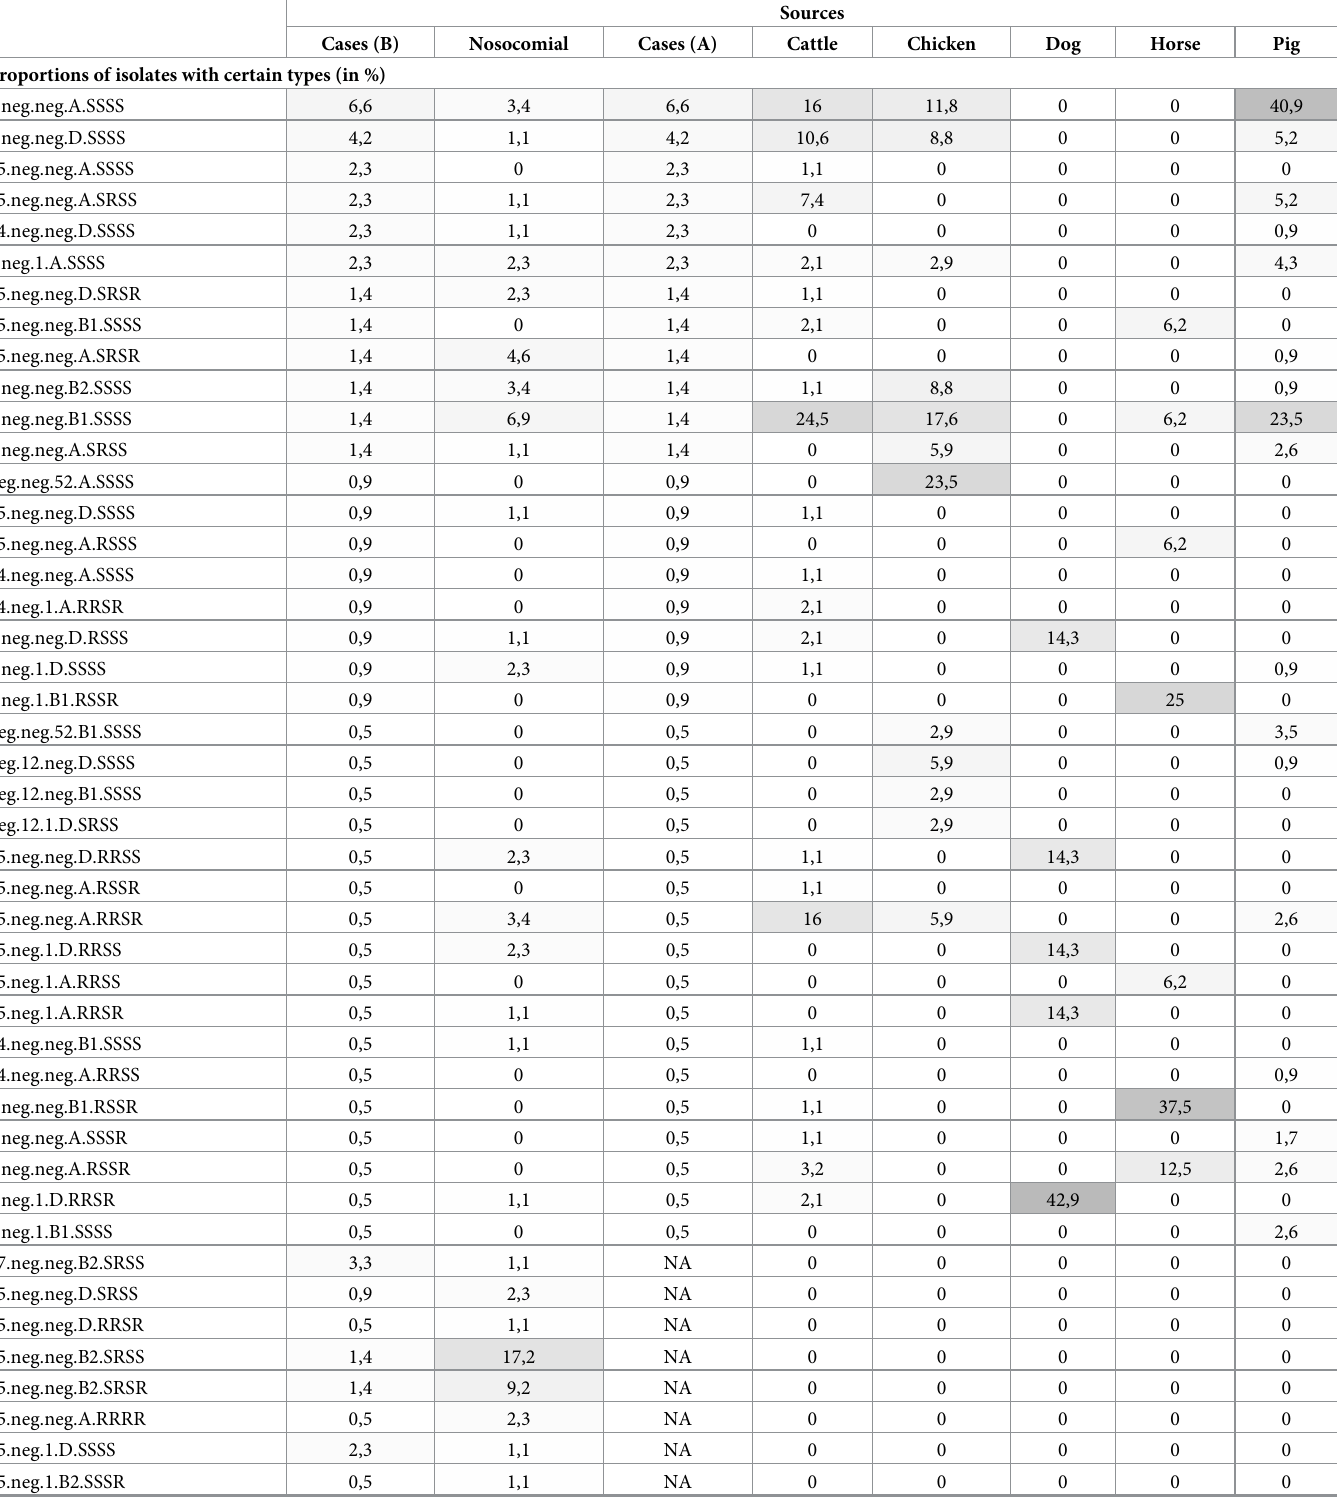
Table 5. Number of matching, unknown and other types for Set A3 and B3. Sources Cases (B) Nosocomial Cases (A) Cattle Chicken Dog Horse